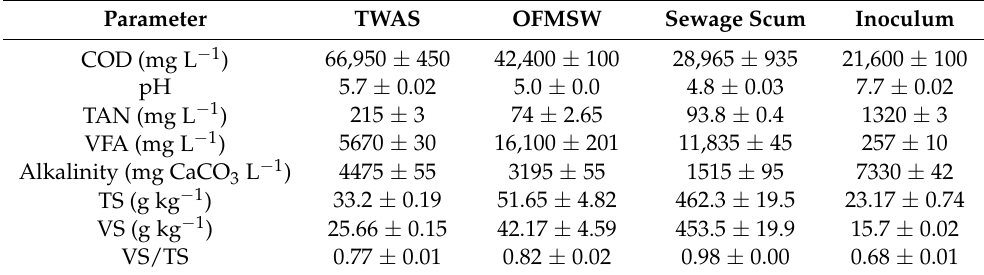
Table 2. Characteristics of the substrates and